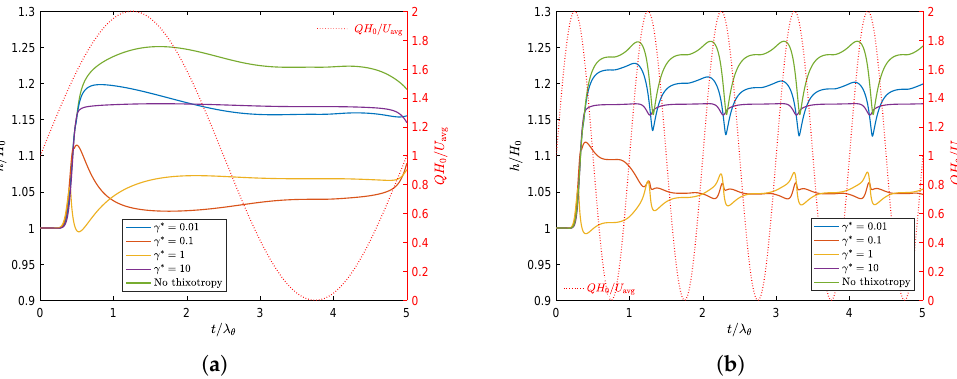
Figure 20. Swell ratio as a function of dimensionless time for the point of the free surface on Γ out , for different values of γ ∗ and a sinusoidal flow rate with dimensionless frequency f ∗ = 1/ t ∗ p , with t ∗ p = t p / λ θ = 5 ( a ), and t ∗ p = t p / λ θ = 1 ( b ). The red dotted line represents the applied flow